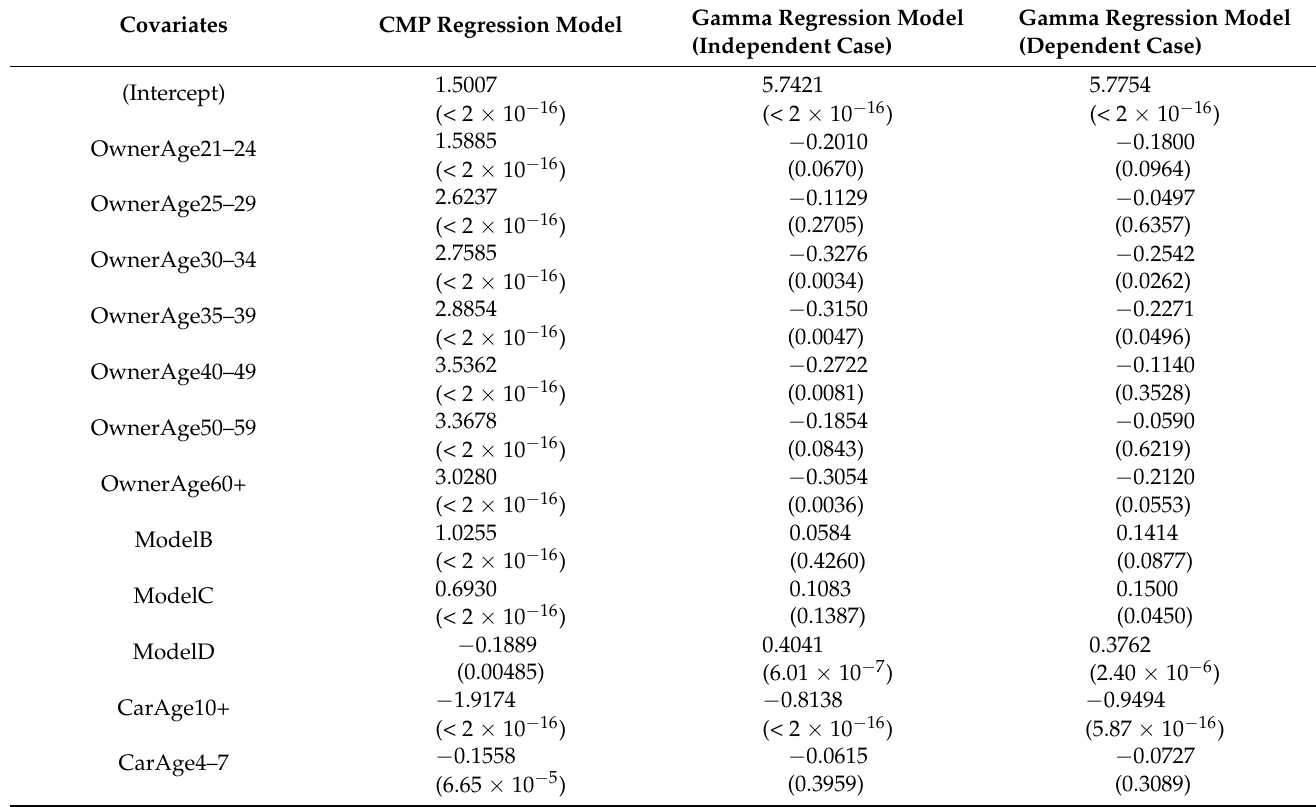
Table 4. Parameter estimates, p -values and AIC for the CMP and gamma regression models for the real-life